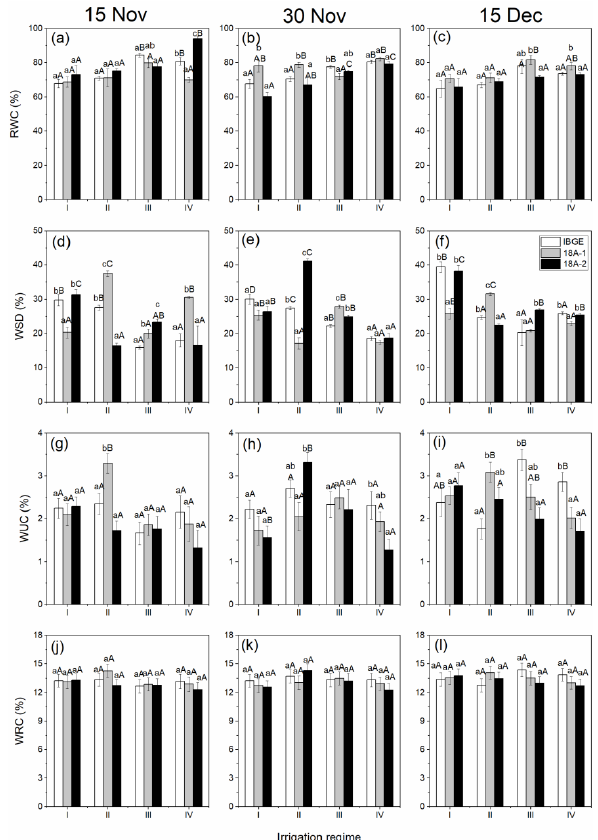
Figure 4. Effects of irrigation regimes on RWC, WSD, WUC, and WRC in wheat cultivars sown on different dates. Bars show mean values of six replicates from two growth cycles and contain standard errors of means ( n = 6). In each panel, bars under each irrigation regime with different lowercase letters show significant differences between wheat cultivars, and bars of each cultivar with different uppercase letters show significant differences between irrigation regimes at p < 0.05. I — irrigation at tillering stage; II — irrigations at tillering and booting stages; III — irrigations at tillering, booting, and flowering stages; IV — irrigations at tillering, booting, flowering, and grain filling stages. Nov = November, Dec = December.